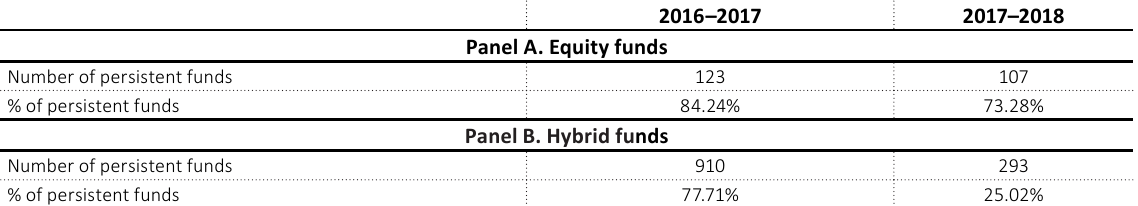
Table 3. Summary of funds’ persistent